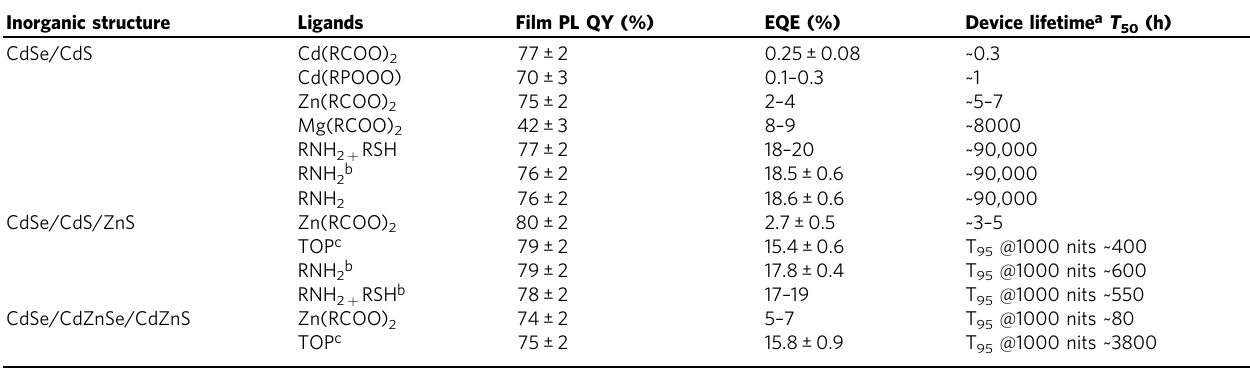
Table 1 PL and EL performance of the QDs with various combinations of shells and ligands. Inorganic